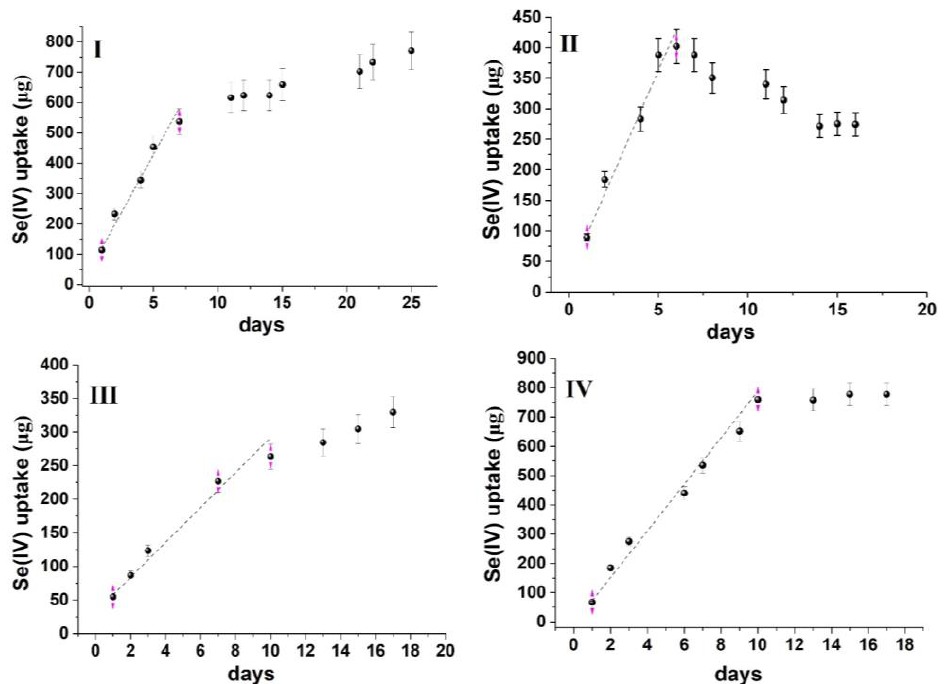
Figure 4. Time series uptake data of Se(IV) oxyanion on MOR − 1@cotton fabric. ( I ) River water mixed at 50 rpm, ( II ) River water mixed at 150 rpm, ( III ) Lake water mixed at 50 rpm, ( IV ) Lake water mixed at 150 rpm.